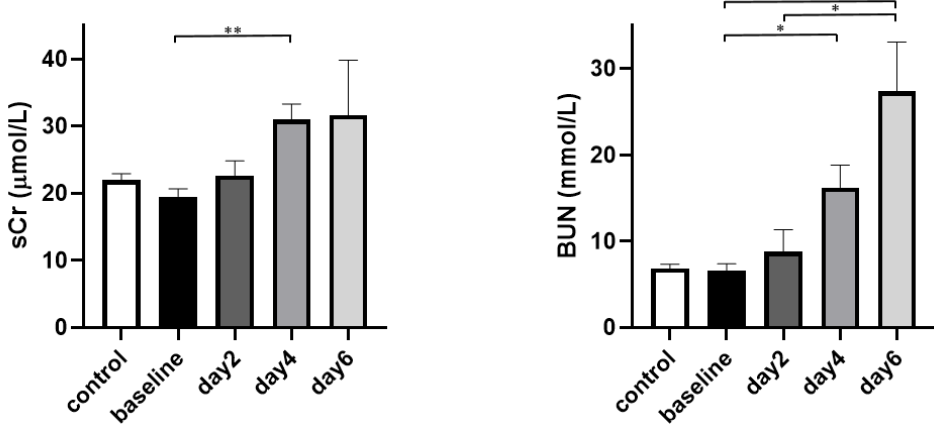
Figure 6. Serum creatinine levels (sCr) ( left ) and blood urea nigrogen (BUN) ( right ) of the control group and the AAI group. ** p < 0.01, * p < 0.05.